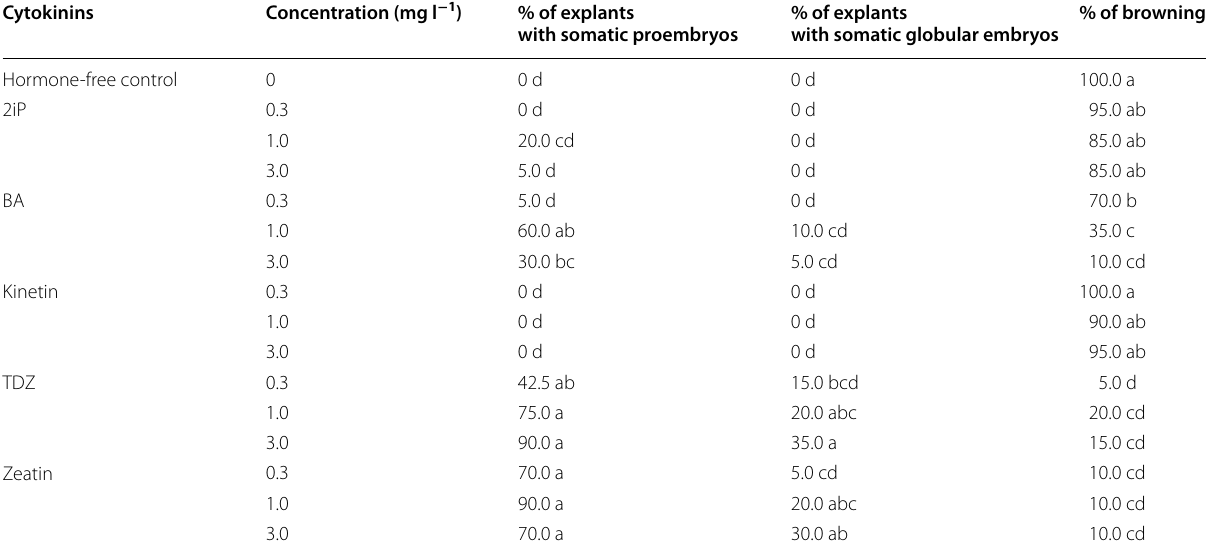
Means within a column followed by the same letter are not significantly different according Duncan’s multiple range test at p